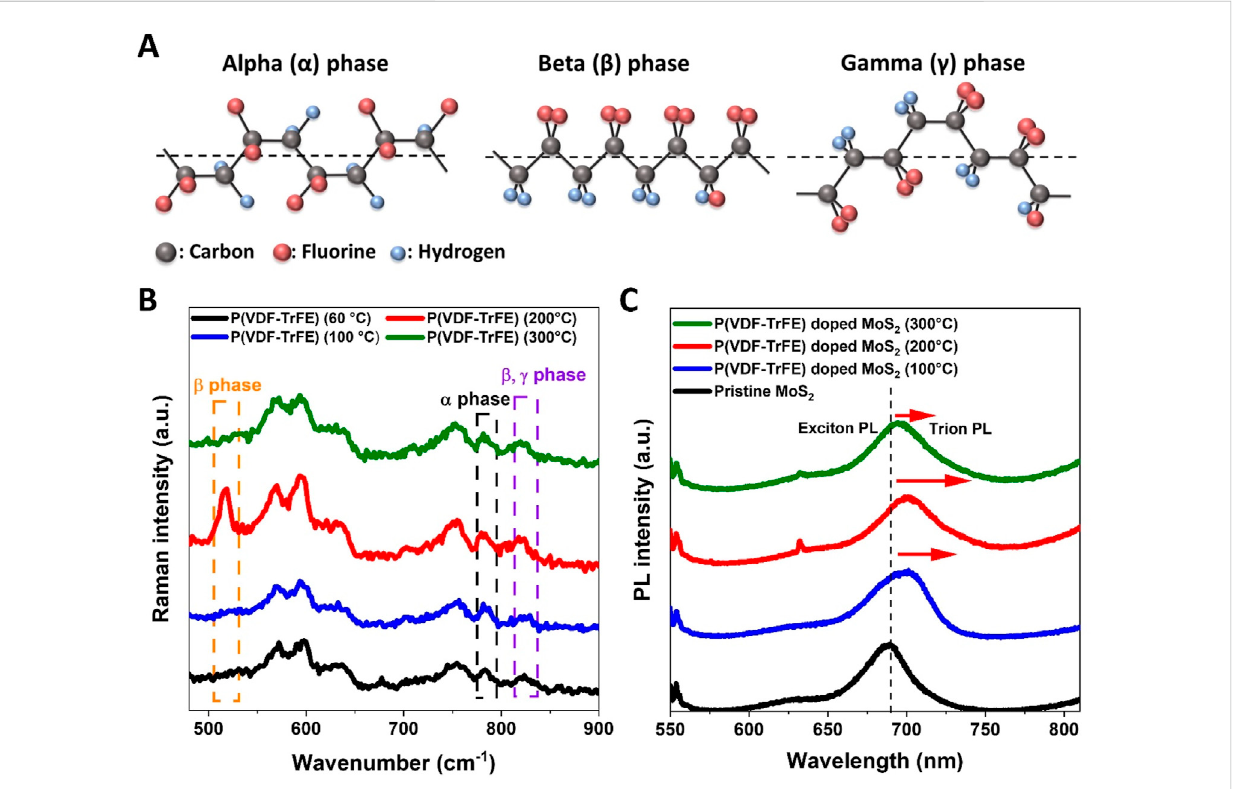
FIGURE 5 (A) Schematic description of different crystalline phases of P(VDF-TrFE) polymer with geometric con fi gurations. (B) Raman spectra of P(VDF-TrFE) fi lms varied with different annealing conditions. Speci fi c peak ranges for α , β , and γ phases are highlighted with black, orange, and violet color dashed boxes. (C) PL spectra of MoS 2 fl akes according to n-type doping conditions. The red arrows indicate the direction of the peak shift compared to the pristine